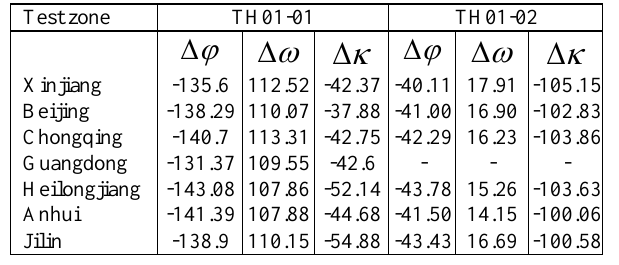
Table 5. Statistics of calibration value of satellite camera angle （ Unit ： second ）